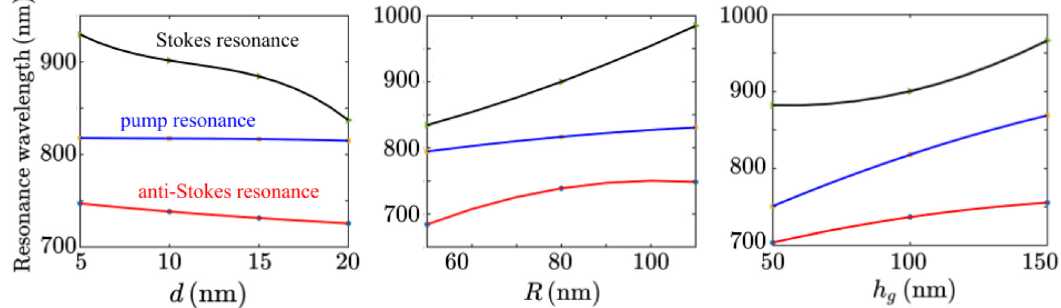
Fig. A1. Spectral position of the three investigated resonance peaks as functions of the disk geometry parameters (left: distance between nanodisks, middle: nanodisk radius) and grating